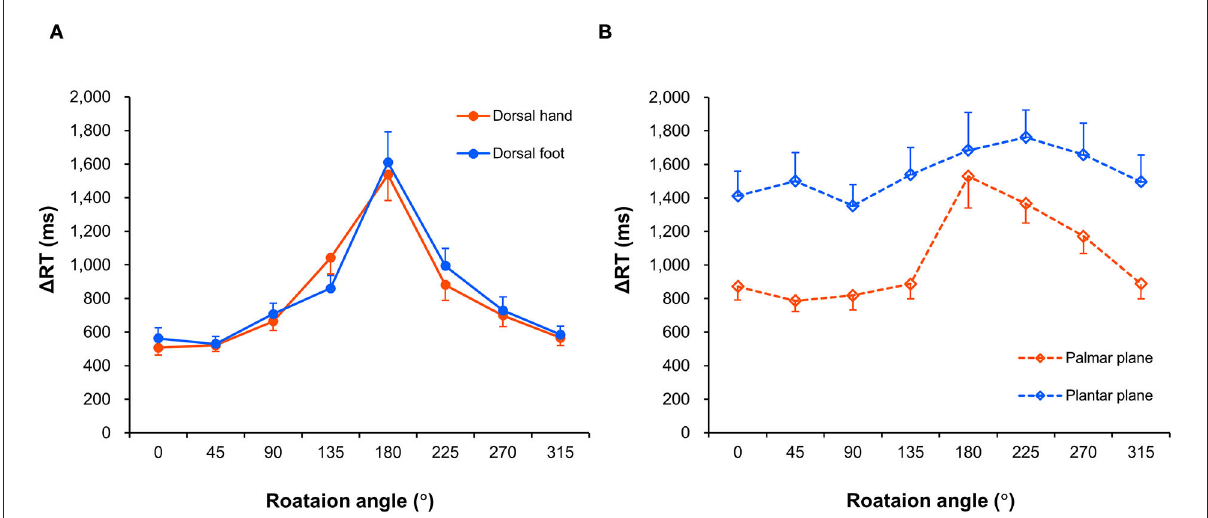
FIGURE5 Mean response times. Change in response times ( 1 RTs) of the dorsal hand and foot images (A) and the palmar plane and plantar plane images (B) across each rotation angle. Mean 1 RTs were calculated by subtracting mean RT values for the arrow images from the mean RT values for each body part image. The data are shown as mean and standard